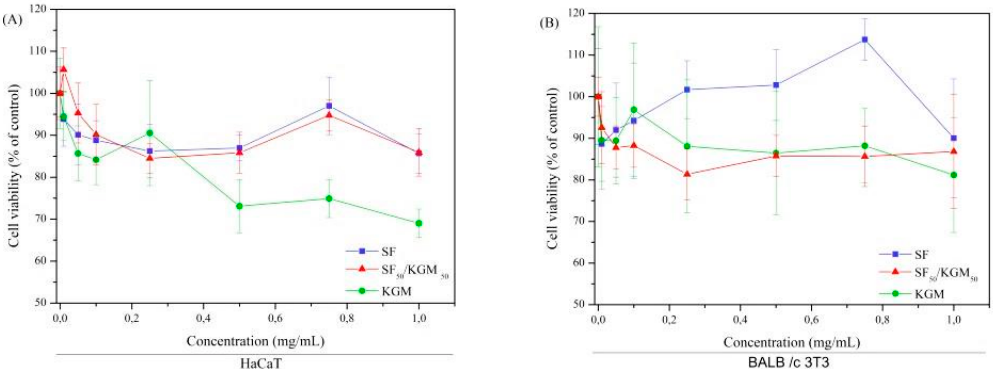
Figure 8. Cytotoxicity of solutions to ( A ) HaCaT and ( B ) BALB/c 3T3 cells. Mean ± SD ( n = 3).